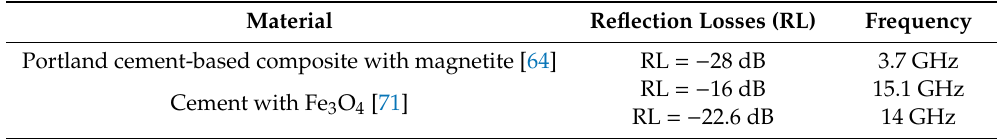
Table 6. Reflection losses of magnetite-based material.